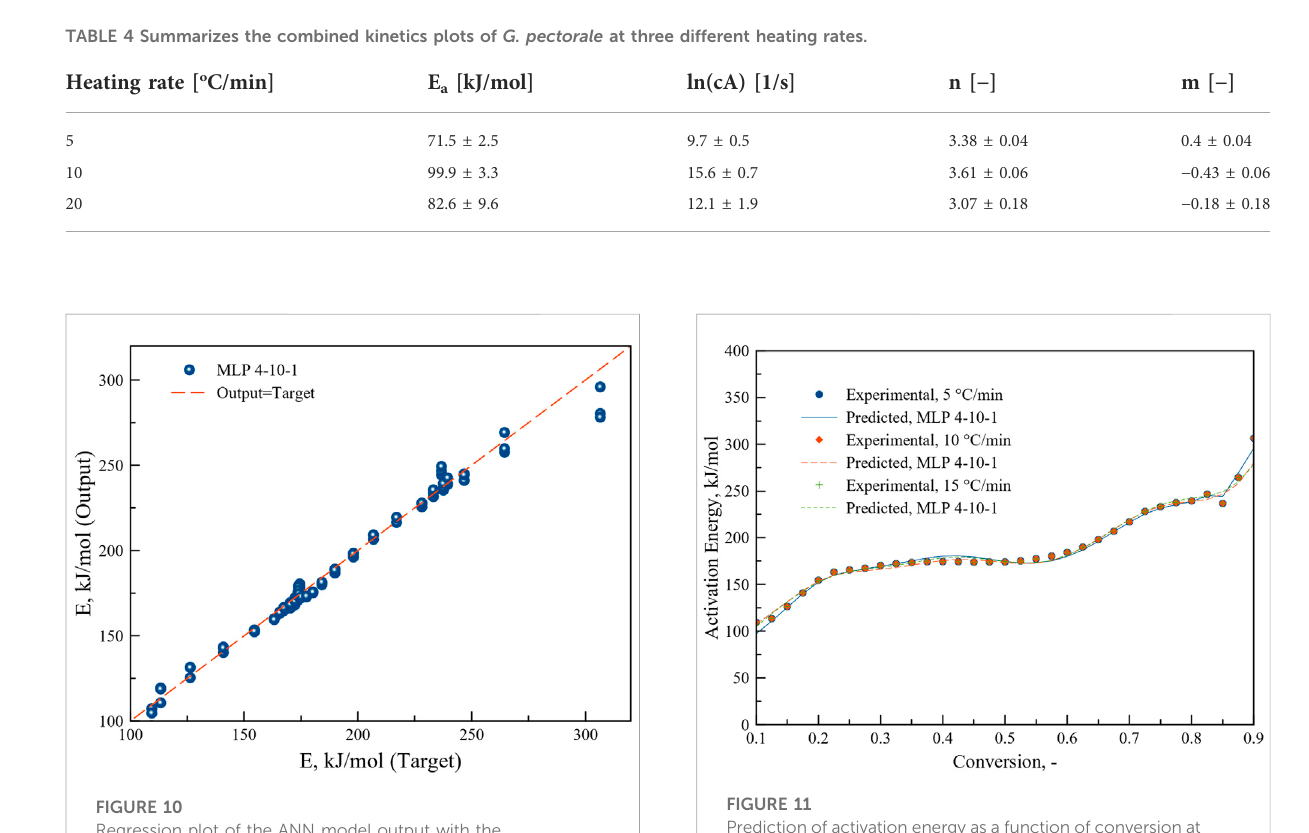
FIGURE 11 Prediction of activation energy as a function of conversion at different heating